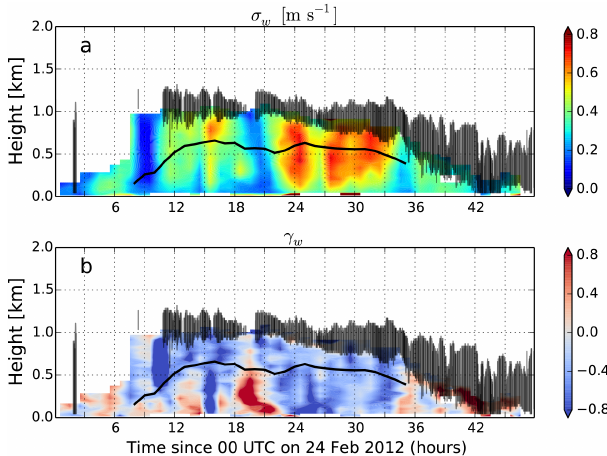
Figure 3. Profiles of (a) the horizontal wind speed and (b) direction over the analysed 2-day period.